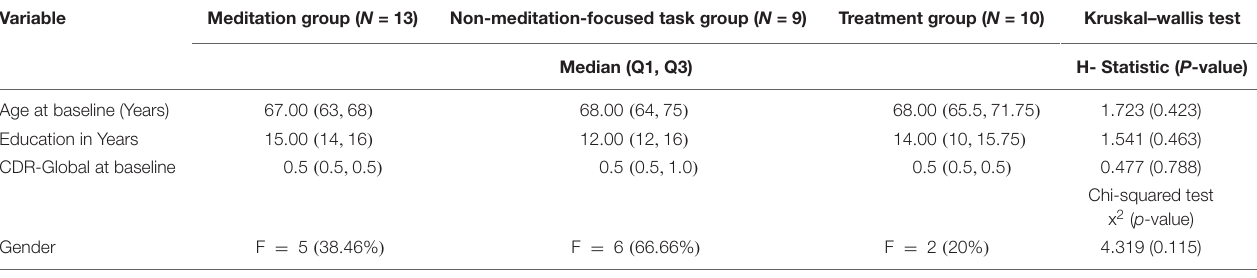
TABLE 1 | Demographics of participants who completed their neuropsychological assessments at baselines and follow-up.